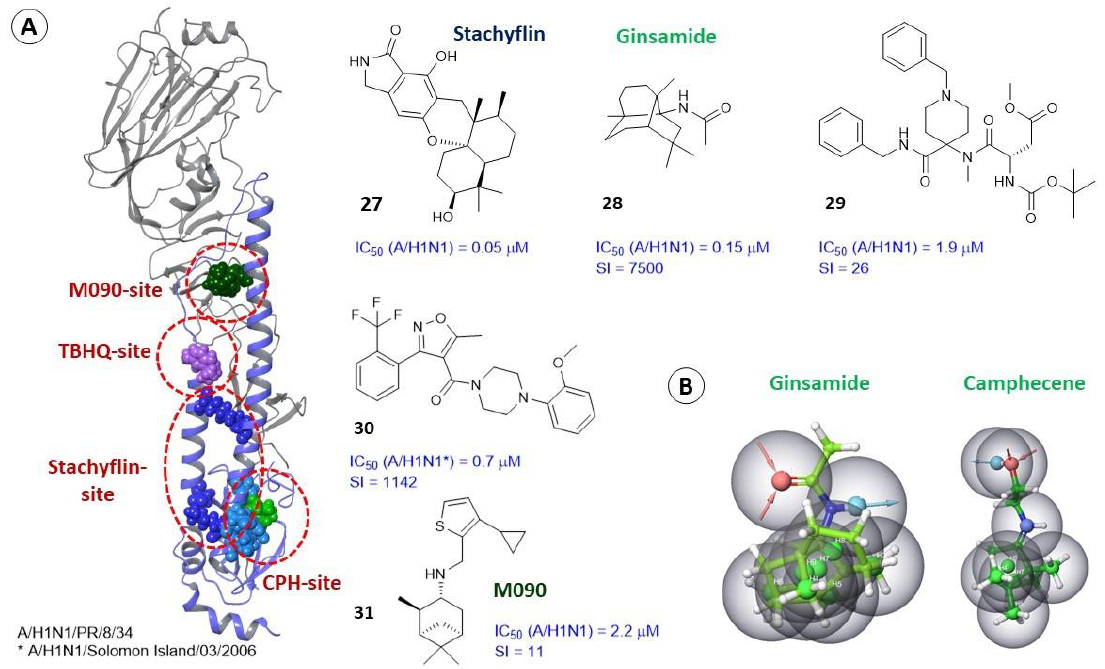
Figure 9. Binding sites of HA inhibitors. The binding sites of stachyflin, camphecene, and M090 ( A ). The pharmacophoric profiles of camphecene and ginsamide ( B ) hydrophobic regions of the molecule are shown in green and donor and acceptor regions are in blue and red, respectively. The protonated nitrogen atom is shown in blue.